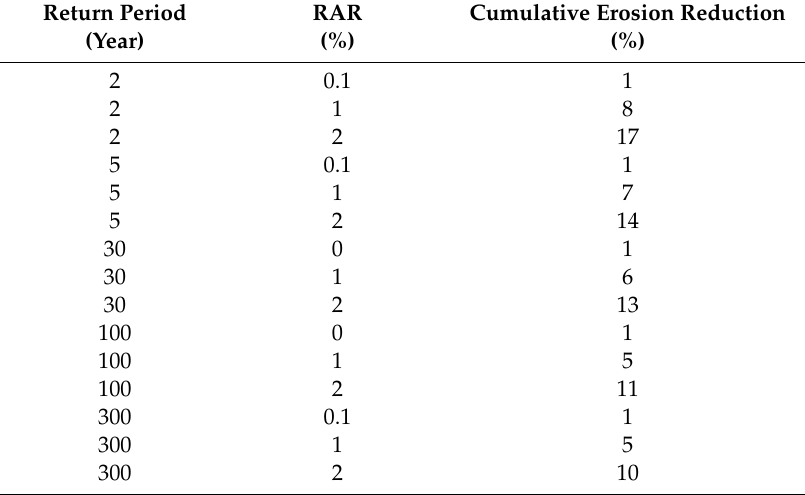
Table 7. Cumulative erosion reduction for the Thur River catchment considering di ff erent return periods and root area